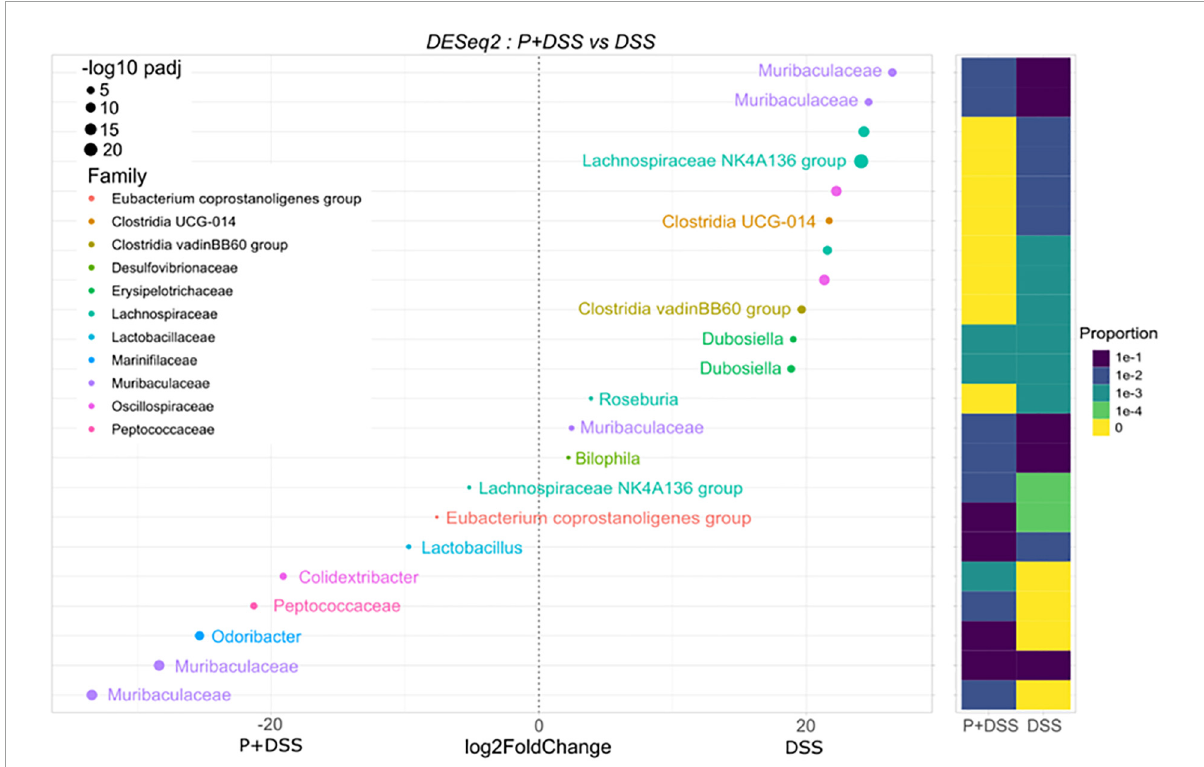
FIGURE6 Prebiotic administration to mothers changes the relative abundance of several bacterial genera in the offspring treated with DSS. Impact of prebiotic supplementation on the bacterial composition was analysed in the luminal content of the distal colons of all groups of mice by DESeq2, which shows differentially abundant ASVs between P + DSS vs. DSS groups of mice. N = 12–24 mice/group at the beginning of the